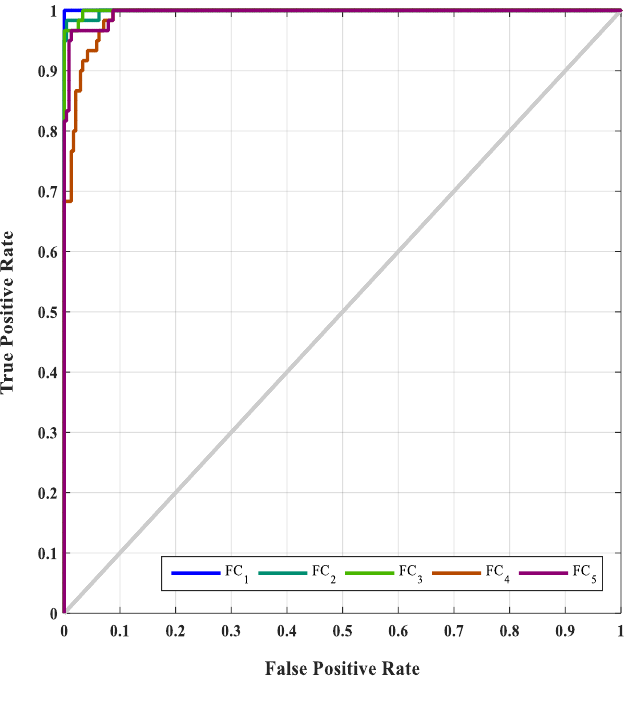
Figure 3. ROC plot for the AAA network.